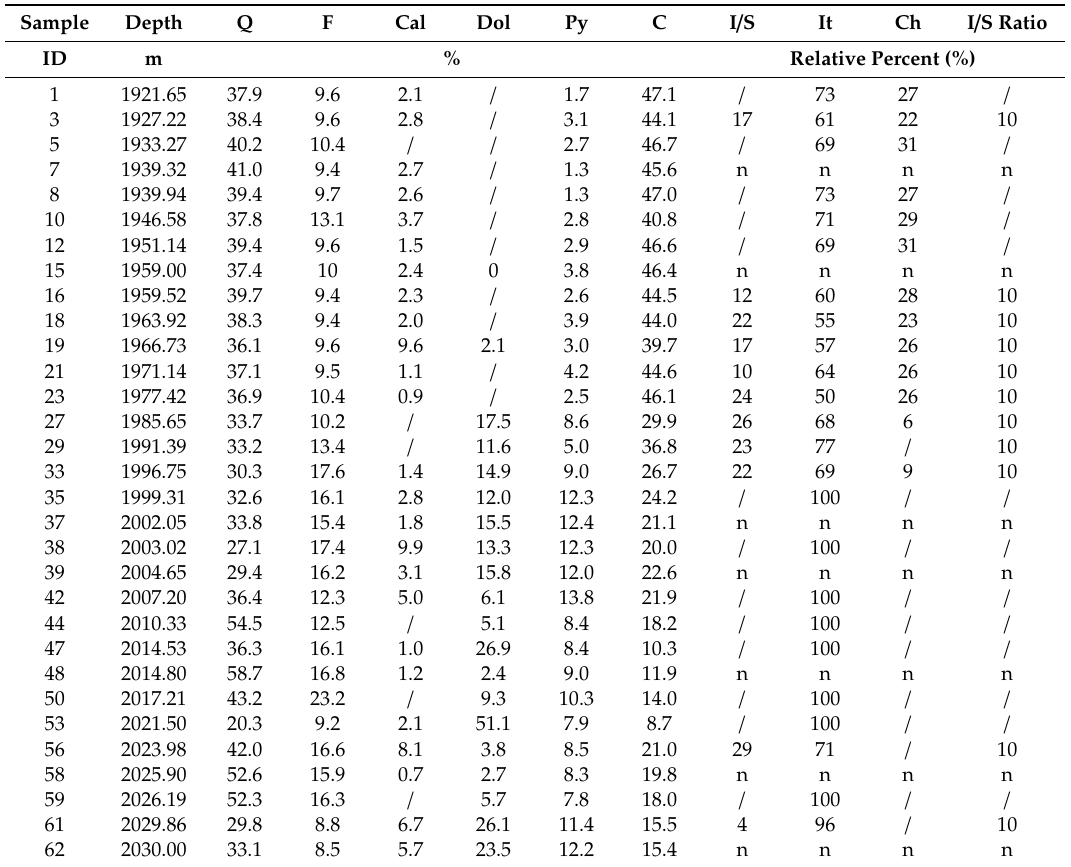
Table 3. Mineralogical composition of the shale